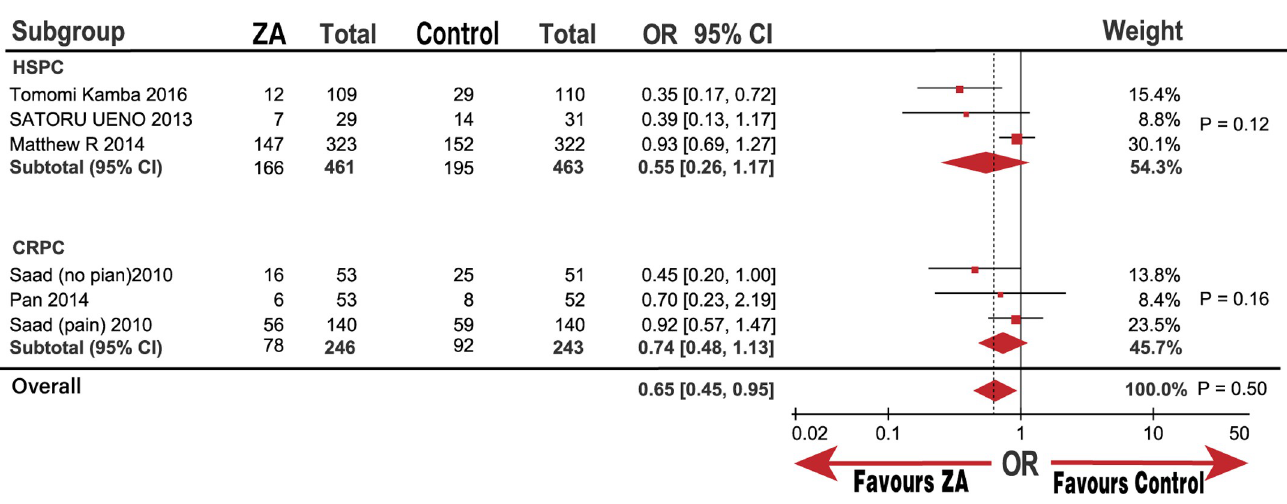
Fig 9. Forest plot odds ratio (OR) of Skeletal related events (SREs) in subgroup of HSPC and CRPC.